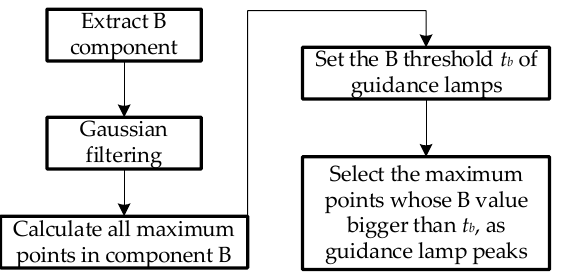
Figure 3. Three-dimensional surface of component B.